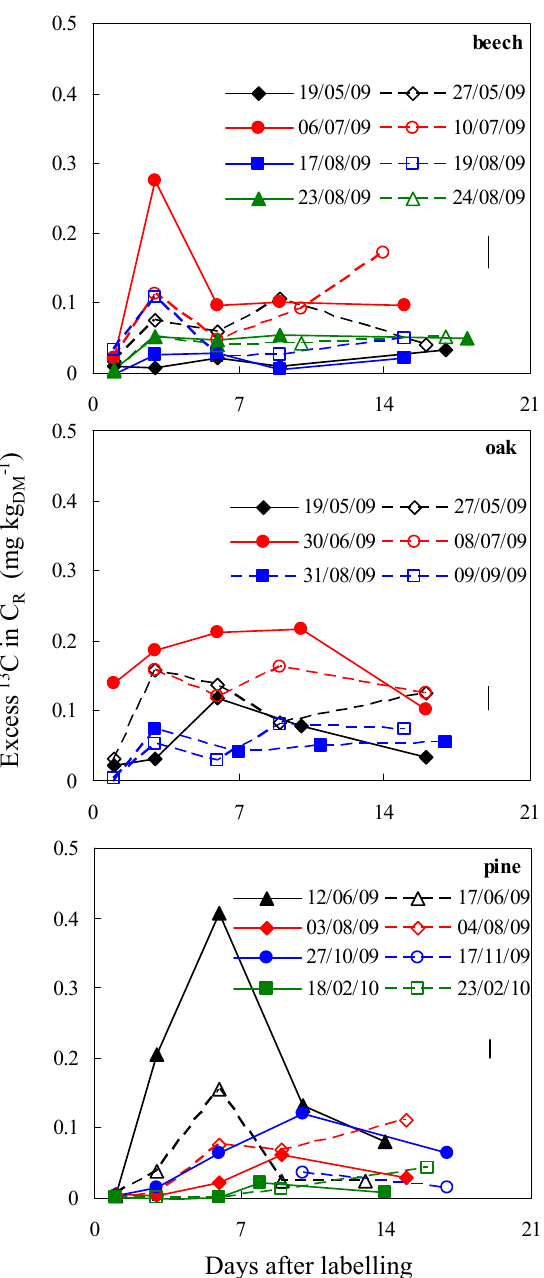
Fig. 6. Time courses of Excess 13 C in root carbon (C R ) after whole crown pulse labelling of beeches (top), oaks (middle) and pines (bottom). Each tree is identified by its date of labelling. There are significant differences between trees ( F 7 , 42 = 5 . 9, F 5 , 9 = 10 . 7 and F 7 , 18 = 24 . 1, for beech, oak and pine respectively, p < 0 . 001) and between sampling dates ( F 32 , 42 = 2 . 0 and F 9 , 15 = 2 . 69 for beech and oak respectively, p < 0 . 05, F 31 , 18 = 7 . 4 for pine, p < 0 . 001). The verticals bars represent the root mean